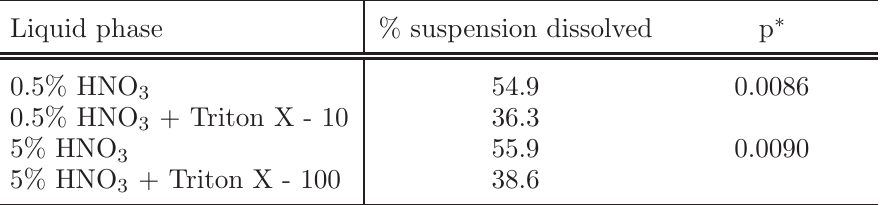
Fig. 1 Pb emission intensity from root slurry in four liquid media. Table 3 Suspension dissolved in the liquid